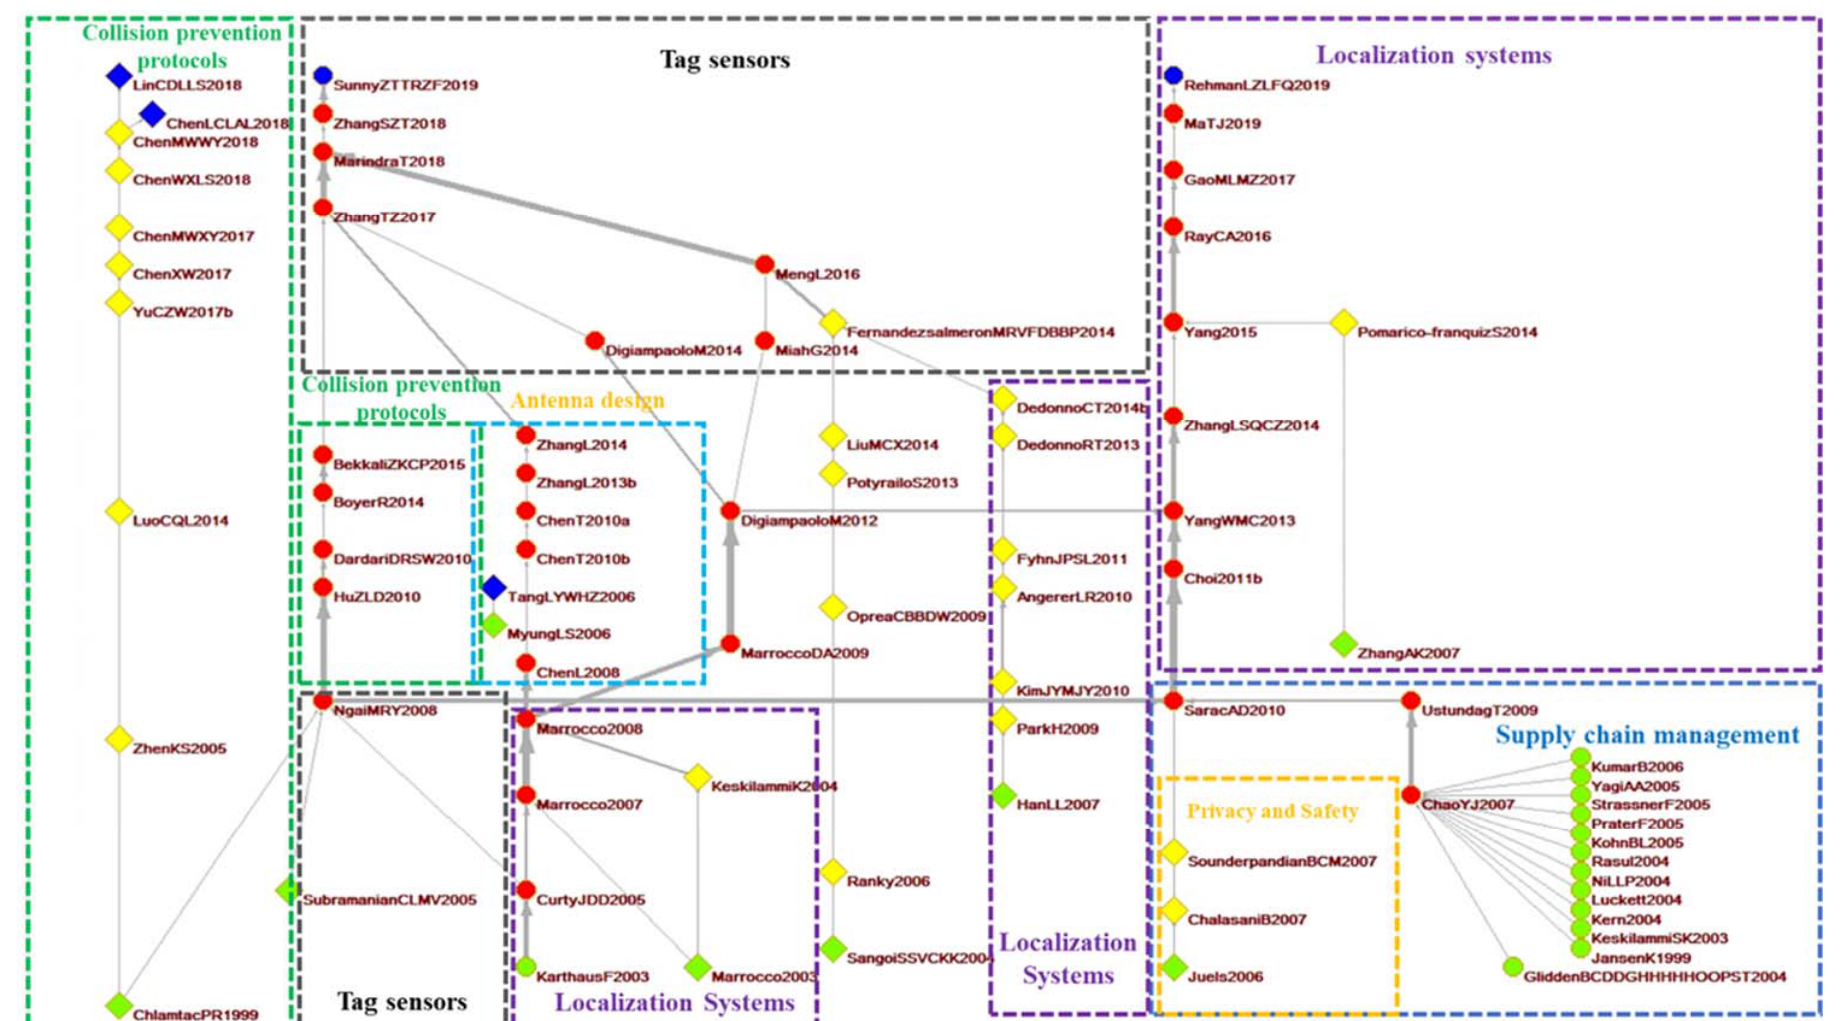
Figure 6 . The development trajectory of academic papers on RFID research. Figure 6. The development trajectory of academic papers on RFID